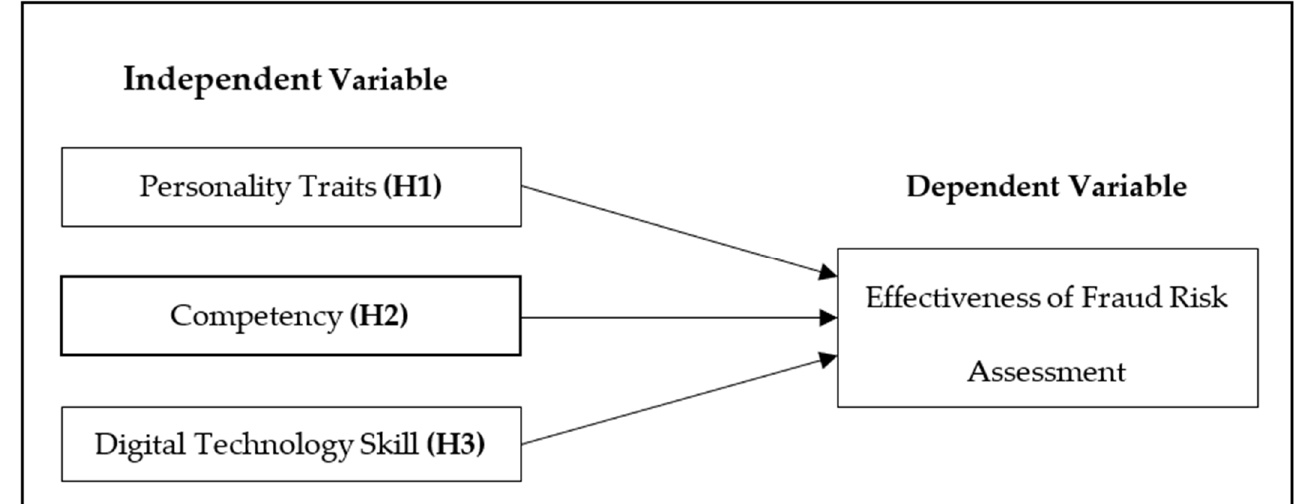
Figure 1. Theoretical Framework.